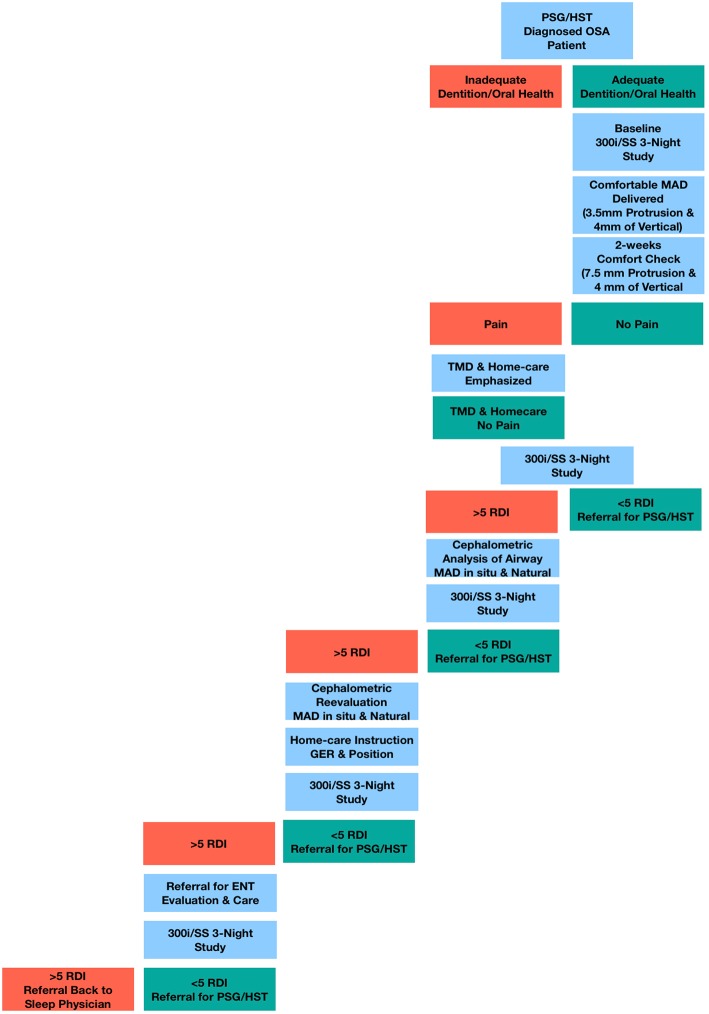
Titration protocol flow chart.